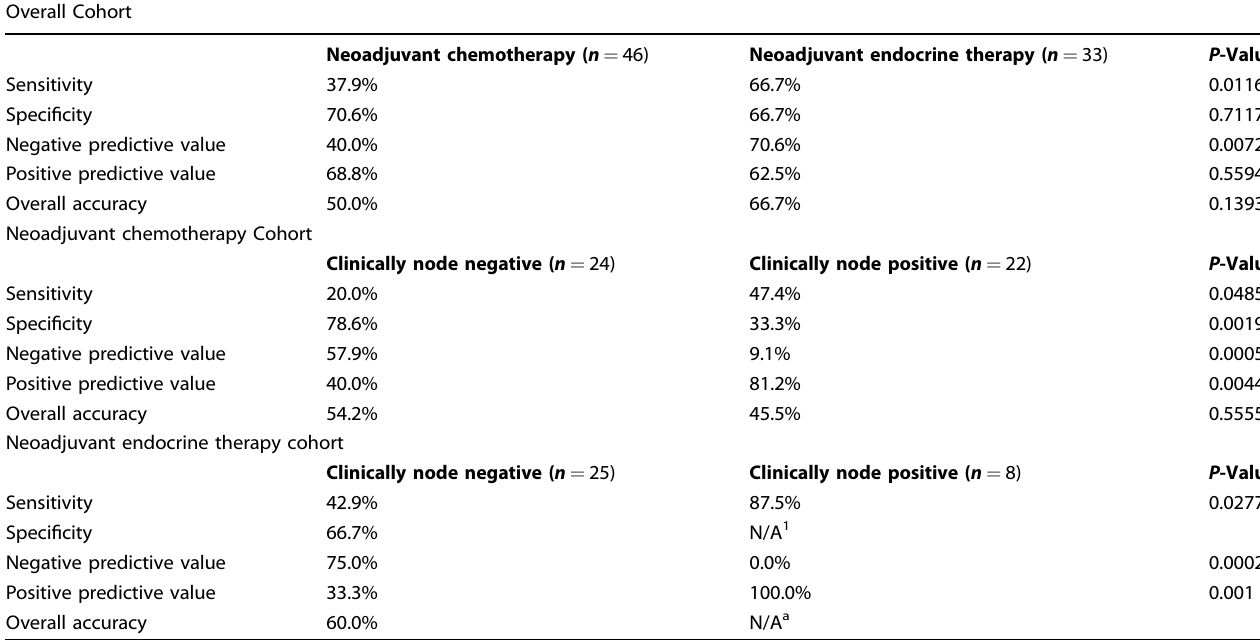
Table 3. Statistical tests evaluating the predictive value of MRI in detecting nodal status after neoadjuvant therapy overall and by clinical node status. Overall